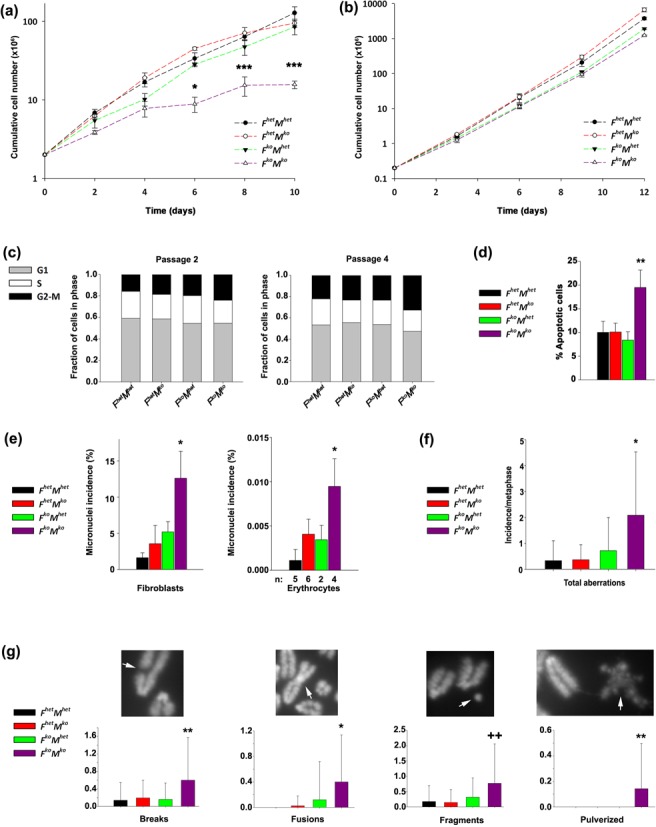
Compromised proliferation and chromosomal instability in FkoMko primary fibroblasts. (a) Proliferation defect of FkoMko primary fibroblasts. Data represent the mean of the cumulative cell number at each assessment day ±SD. *P < 0.05, ***P < 0.001 versus all genotypes by two-way ANOVA followed by Holm-Sidak posthoc test. (b) Proliferation of SV40-transformed fibroblasts. Data were analyzed by two-way ANOVA; however, no statistically significant differences were observed. (c) Passage-dependent accumulation of FkoMko fibroblasts in G2/M. Significant differences in cell cycle were observed in FkoMko cells at passage 4. Specifically, a significant accumulation of FkoMko fibroblasts in G2/M was observed from passage 2 to passage 4. Data represent the average percentage of cells in each phase (n = 3) for a total of 100%. At passage 4, G1 phase, P < 0.001 versus all other genotypes. For the S phase, P < 0.05 versus all genotypes and for FkoMhet versus FhetMhet. Data were analyzed by two-way ANOVA followed by Holm–Sidak post hoc test. (d) Increased propensity for FkoMko fibroblasts to undergo spontaneous apoptosis. Data represent the mean percentage of cells in both early and late apoptosis (n = 3). **P < 0.01 versus all genotypes based on the results of one-way ANOVA followed by Holm–Sidak post hoc test. (e) Incidence of micronuclei in primary untreated embryonic fibroblasts and primary untreated erythrocytes,*P < 0.05 for FkoMko versus all genotypes based on the results of one-way ANOVA followed by Holm–Sidak post hoc test; (f) frequency of total aberrations/metaphase in primary fibroblasts plotted as incidence/metaphase. Data represent the mean incidence per metaphase ±SD, *P < 0.05 versus all genotypes by one-way ANOVA followed by Holm–Sidak post hoc test. (g) Incidence of chromosome aberrations: breaks and pulverized **P < 0.01 versus all genotypes, fusions *P < 0.05 versus all genotypes, fragments ++P < 0.01 versus FhetMko and FhetMhet. All data were analyzed by one-way ANOVA followed by Holm–Sidak post hoc test.